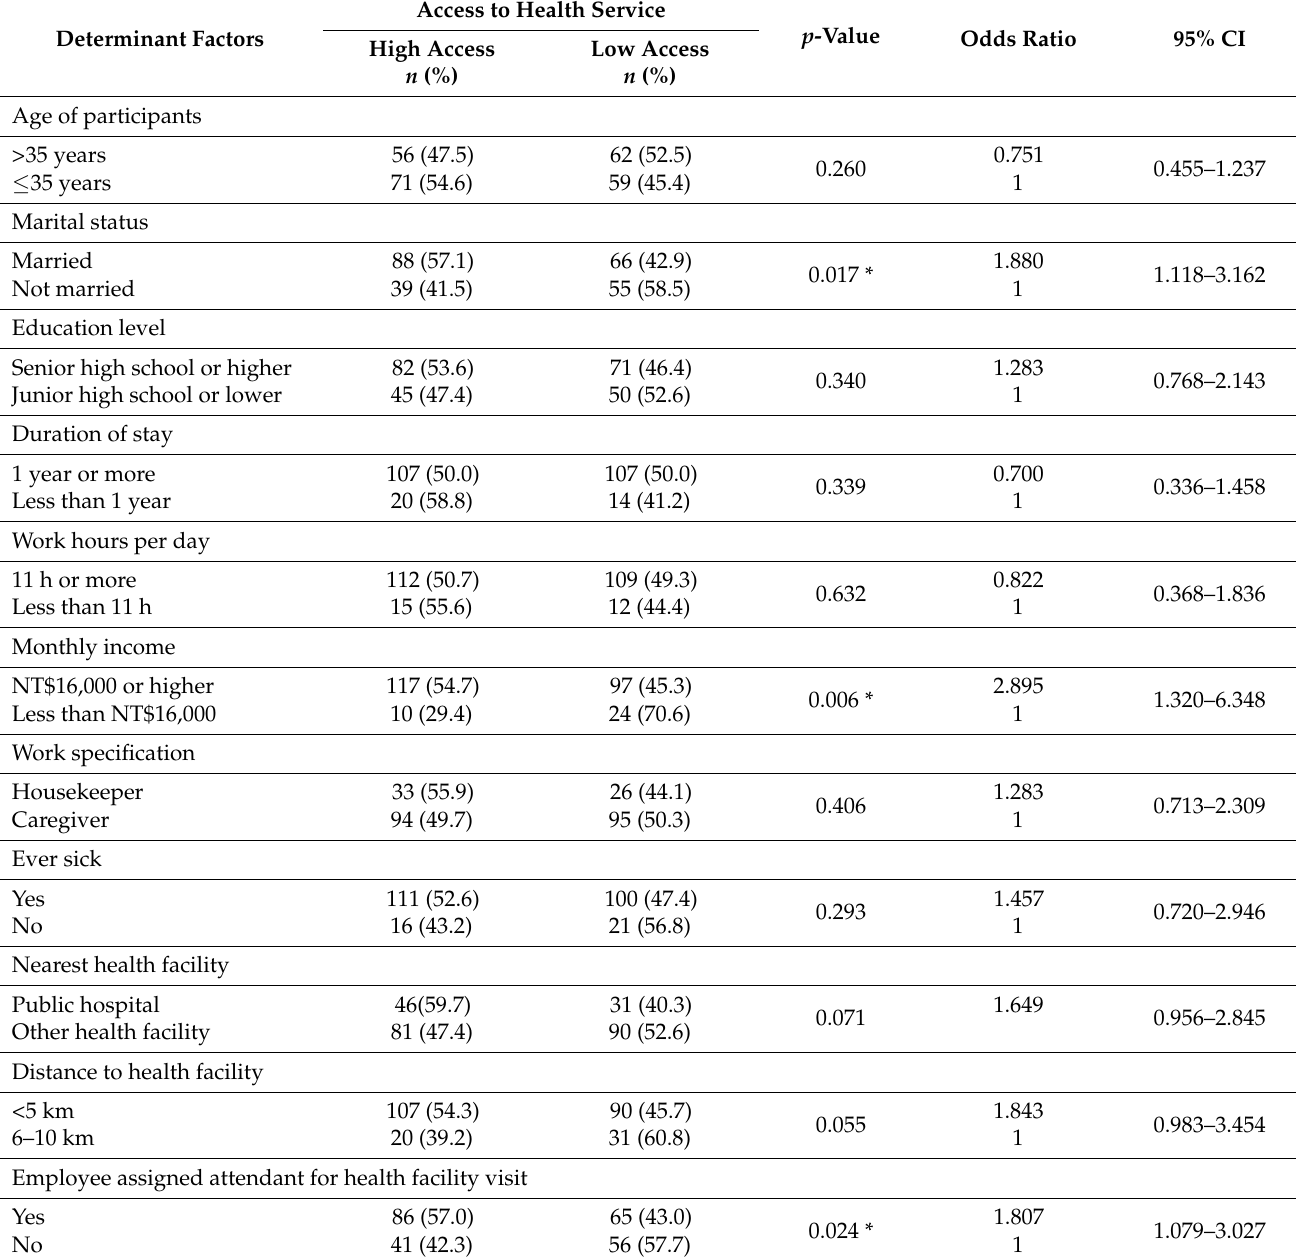
Table 3. Bivariate analysis among determinant factors and health service